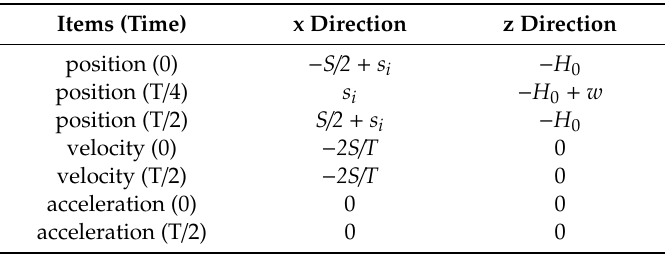
Table 2. The limiting conditions of the swing phase (0–T /